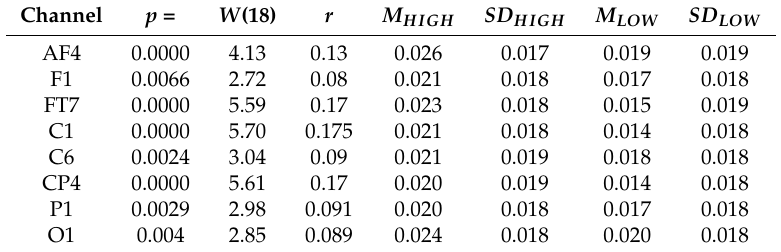
Table A9. Eyes-Open (EO) setting. Channel-wise paired Wilcoxon rank sum tests for eight channels (AF4, F1, FT7, C1, C6, CP4, P1, and O1) in which significantly higher distributed TEs were associated with HIGH stress-susceptible group. p , W , and r refer to p -value, test-statistics, and the effect size for Wilcoxon rank sum tests. M and SD are the mean and standard deviation of these channels’ distributed TE values for HIGH and LOW stress-susceptible groups. The subscripts to M and SD mark the two groups.